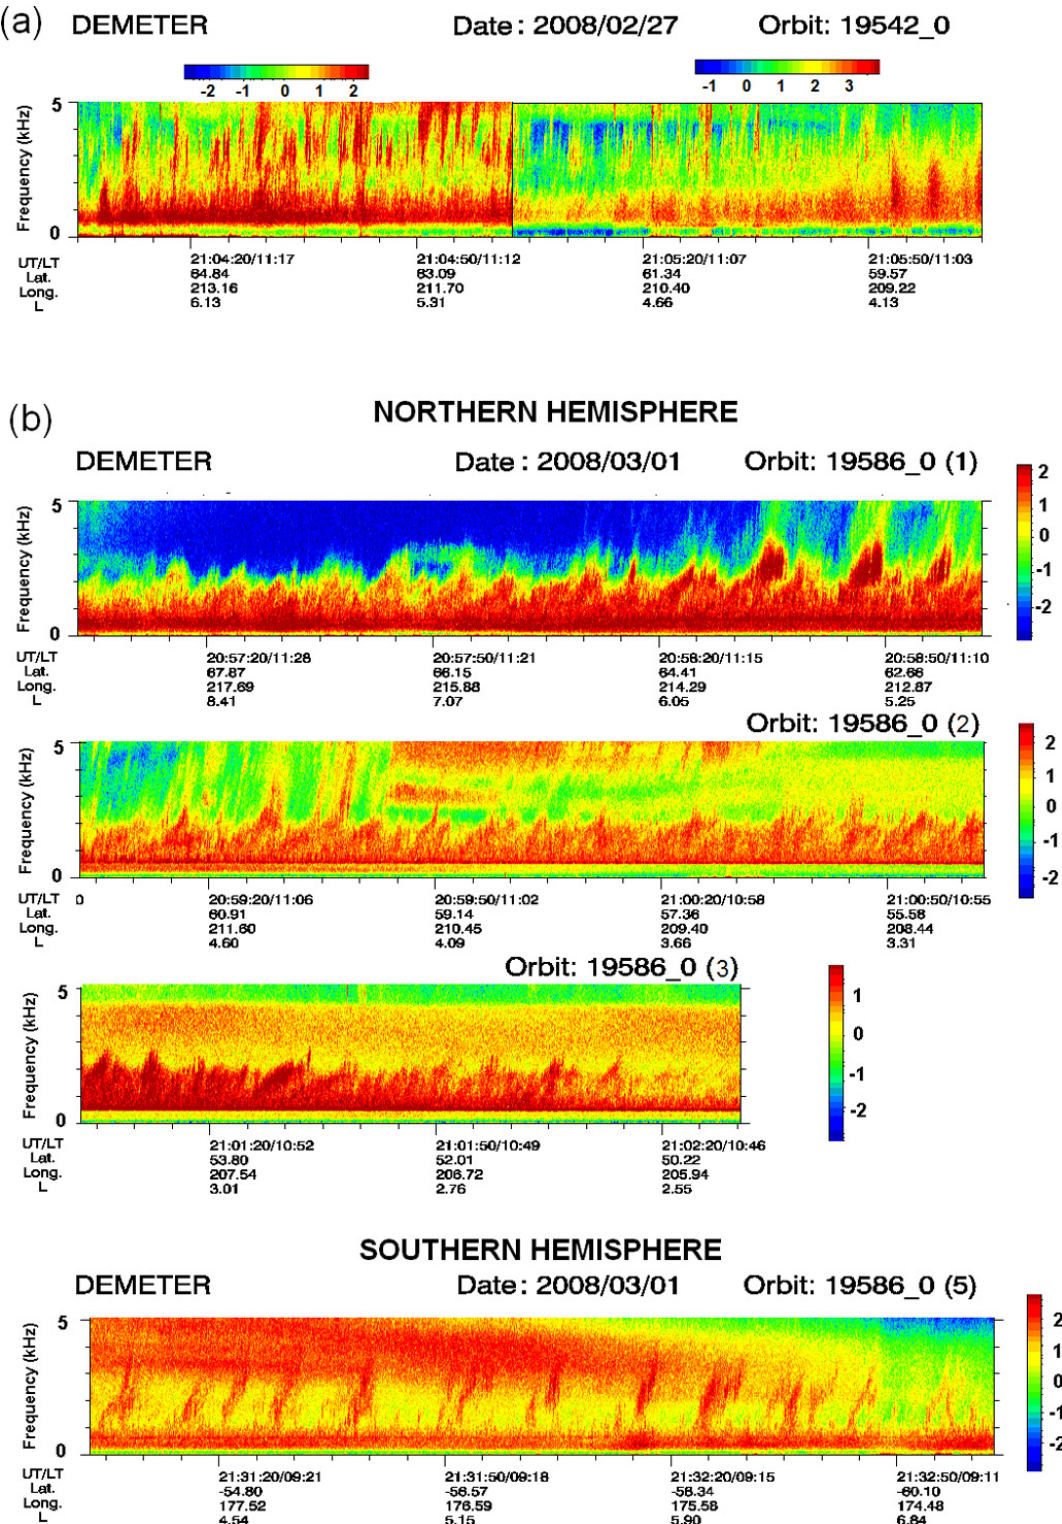
Fig. 4. DEMETER VLF data (a) on 27 February 2008 as the united data from two parts of the orbit with the different scales and (b) on 1 March 2008. The latitudes and longitudes are given in the geographic